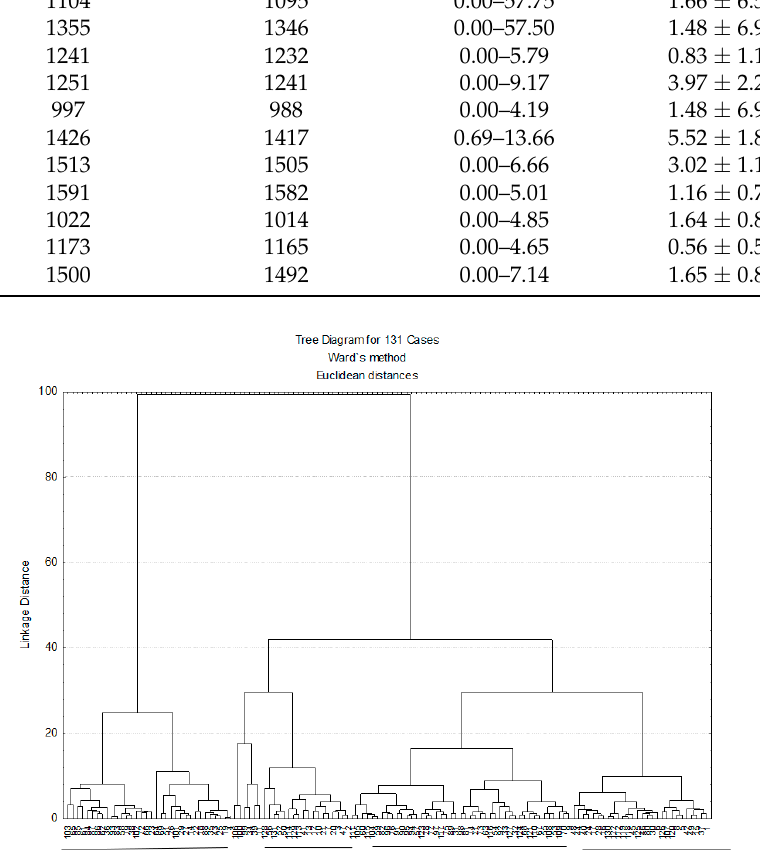
Figure 2. Two dimensional dendrogram of Thymus pulegioides habitats by chemotypes determining the main chemical compounds of essential oils.